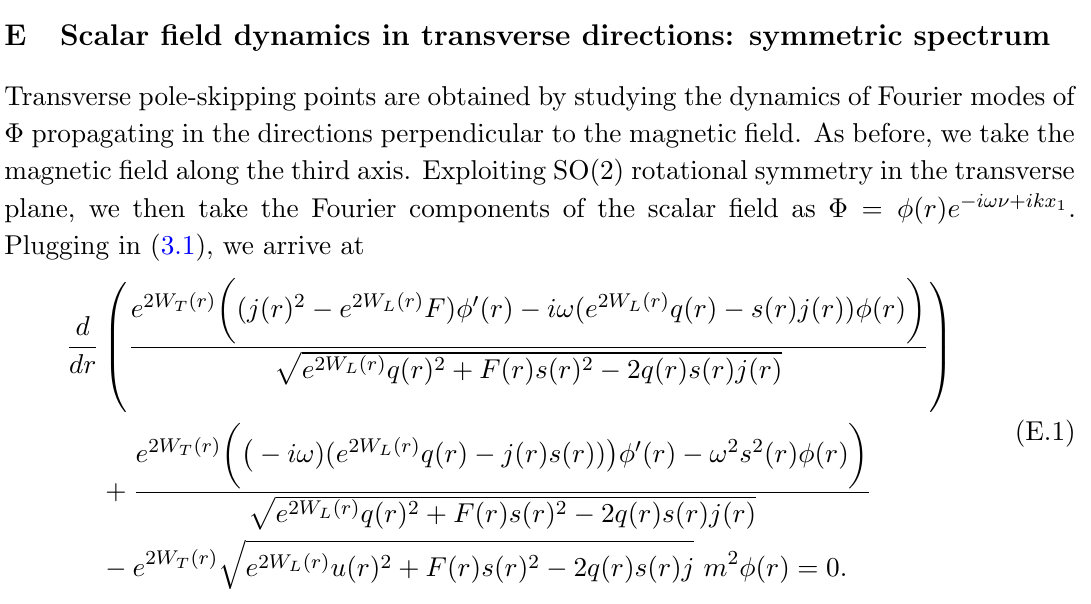
Figure 4 . Spectrum of chaos points together with the pole-skipping points of a boundary operator dual to a scalar (cid:12)led, in the transverse channel. In the left panel, the mass of scalar (cid:12)eld in the bulk is m = 0 and in the right panel m = 2. Orange and red points are related to non-chiral matter at (cid:23) = 0 and b = 0. Blue and green points correspond to a chiral matter at (cid:23) = : 5 and b = :